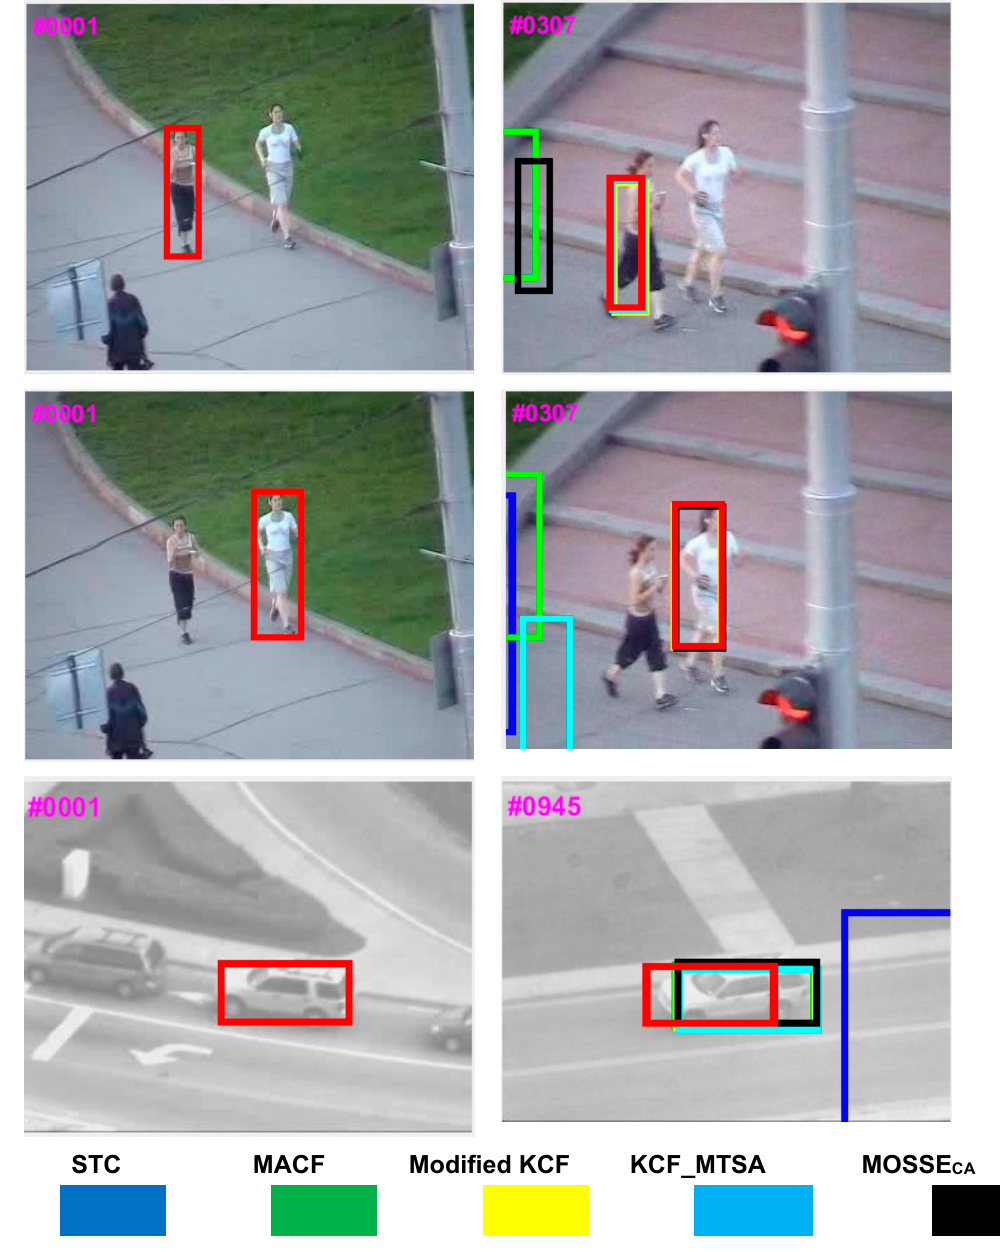
Figure 8. Qualitative comparison for the OTB-100 dataset [26].